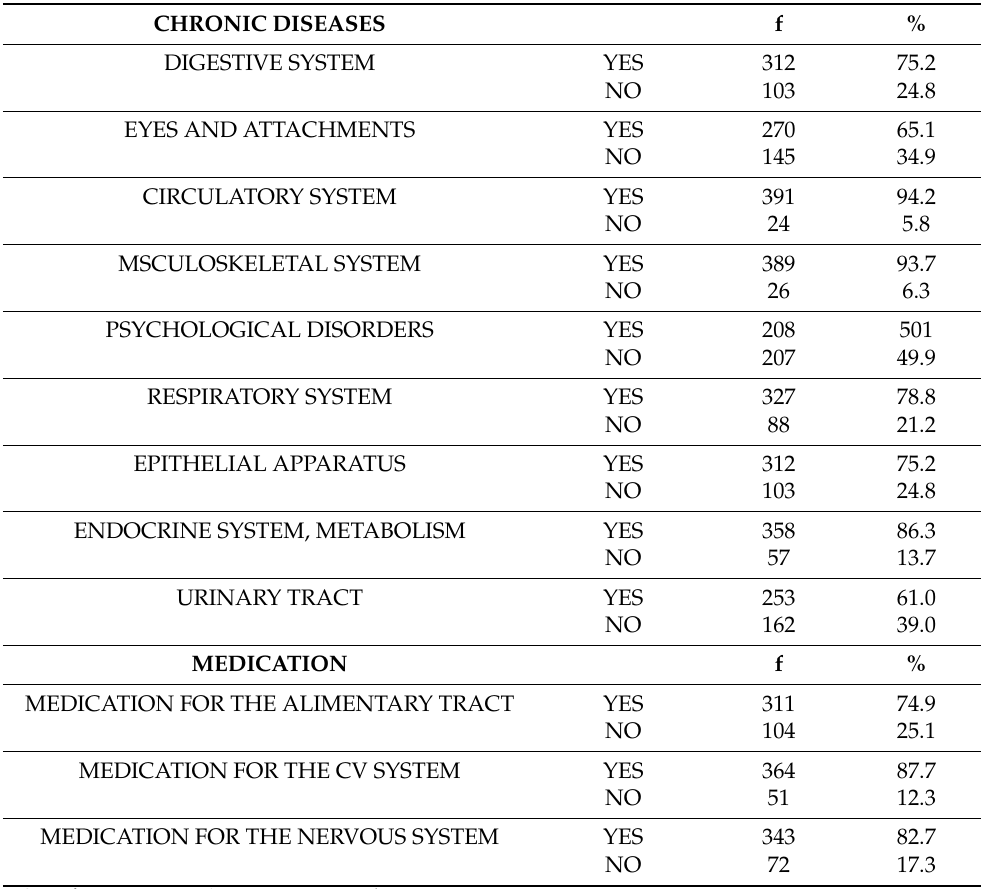
Table 3. The chronic diseases and the medication. CHRONIC DISEASES